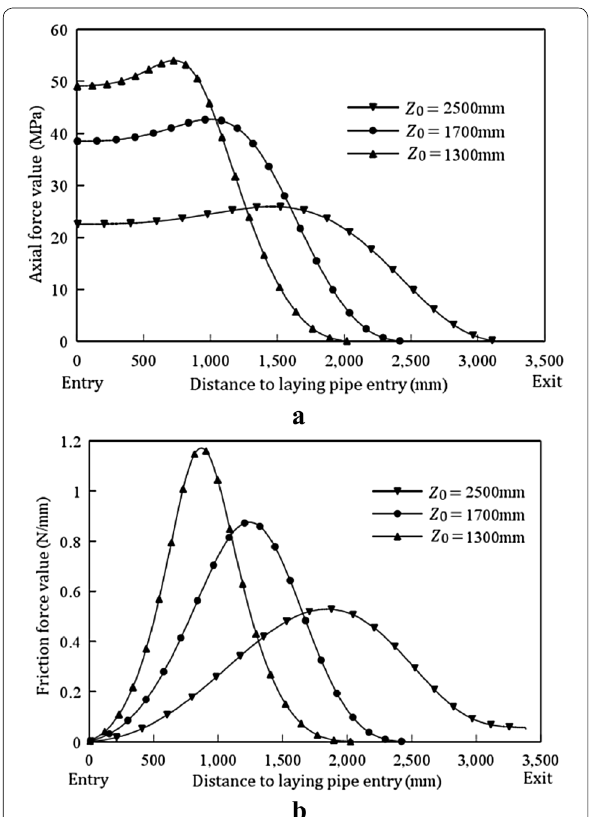
Figure 21 Numerical results with different θ 0 : a Axial force in the design laying pipe; b Friction force in the design laying